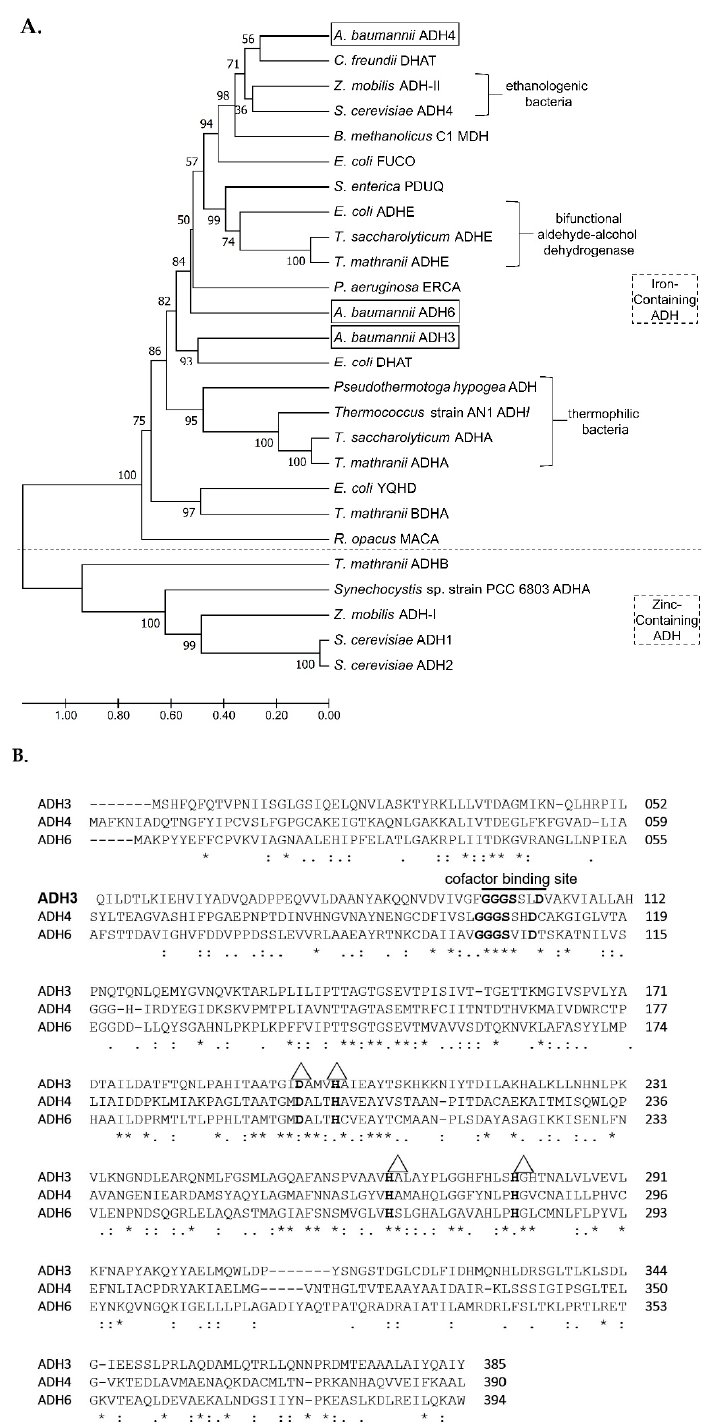
Figure 1. ( A ) Cladogram of iron-containing Adh genes in A. baumannii compared with 23 other Adh genes from 14 organisms. The scale bar indicates the number of nucleotide substitutions per site. ( B ) Amino acid alignment of three FeADHs (ADH3, ADH4, ADH6) in A. baumannii . Δ indicates the positions of the four key iron-binding sites (D, H, H, H). Asterisks (*) indicate positions with single fully conserved amino acid residues; colons (:) indicate positions with conservation between residues of strongly similar properties (scoring > 0.5 in the Gonnet point accepted mutation 250 matrix); and periods (.) indicate positions with conservation between groups of weakly similar properties (scoring ≤ 0.5 in the Gonnet point accepted mutation 250 matrix).